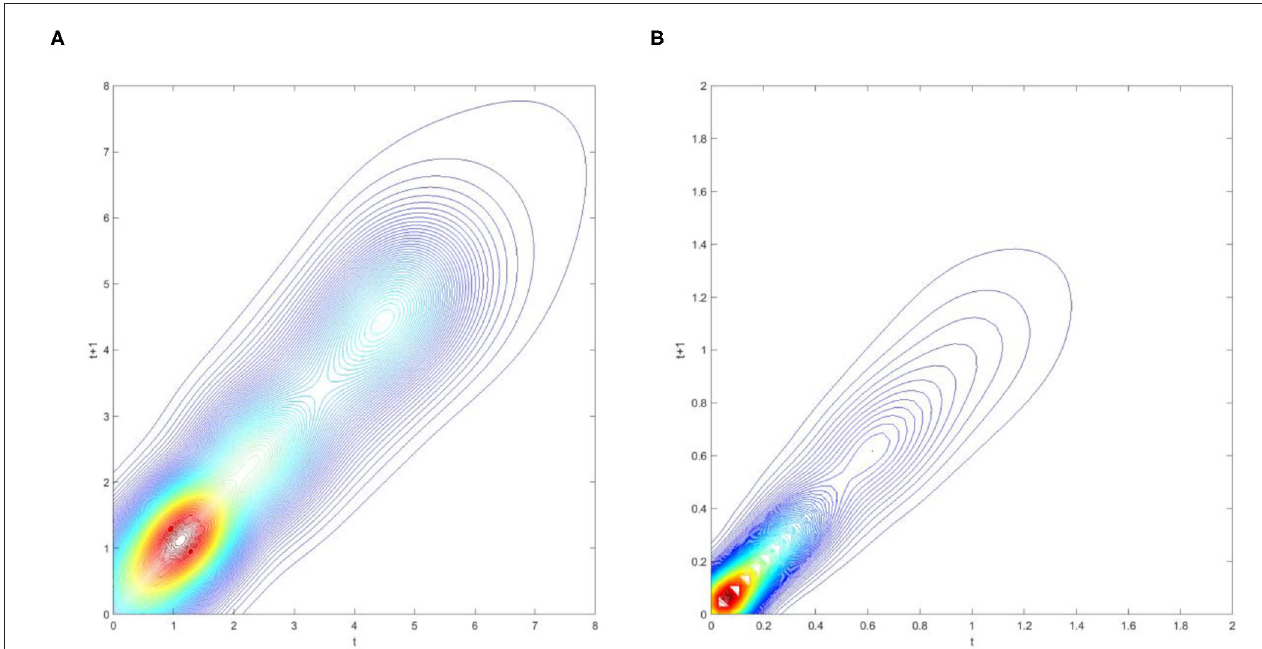
FIGURE 6 | Contour map of transition probability kernel for the RIVAPC of countries for the Global North and the Global South with annual transitions. Source: authors’ calculation. N.B. The vertical axis indicates the RIVAPC value in year t and the horizontal axis indicates RIVAPC value in year t + 1. (A) Global North. (B) Global